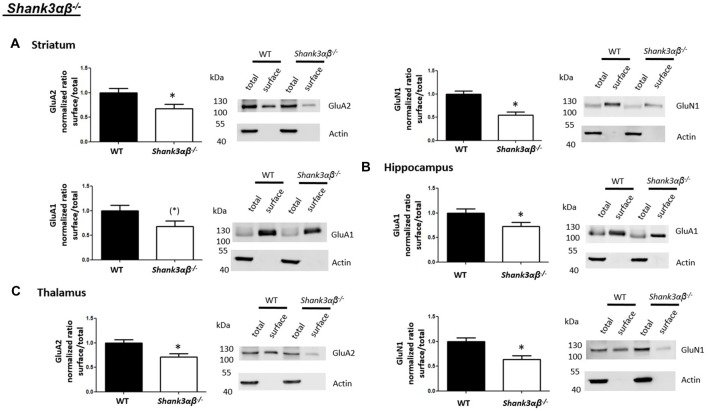
Analysis of cell surface glutamate and GABA receptor subunits in ASD related brain regions of Shank3αβ−/− mice. (A–C) Representative WBs showing band intensities of total protein and cell surface sample in striatum (A), hippocampus (B) and thalamus (C) of wildtype and Shank3αβ−/− mice reveal a downregulation of cell surface glutamate receptor subunits in Shank3αβ−/− mice. Immunodetections were carried out with antibodies directed against GABAARα1, GluA2, GluN1, GluA1, mGluR5, and actin. For GABAARα1, GluA2 and actin all brain regions were analyzed. For GluN1 all brain regions except the cerebellum were analyzed. For GluA1 all brain regions except the thalamus and cerebellum were analyzed. For mGluR5 only the hippocampus was analyzed. Only statistically significant data (p < 0.05; see below) or data with strong trends (p < 0.10; see below) is shown. To the left of each representative WB, the respective quantification of the surface/total ratio is shown. Vertical axis shows the mean fold change vs. the wildtype control (control set to a value of 1). Error bars are SEMs. n ≥ 5 per group. *p < 0.05, (*)p < 0.10.